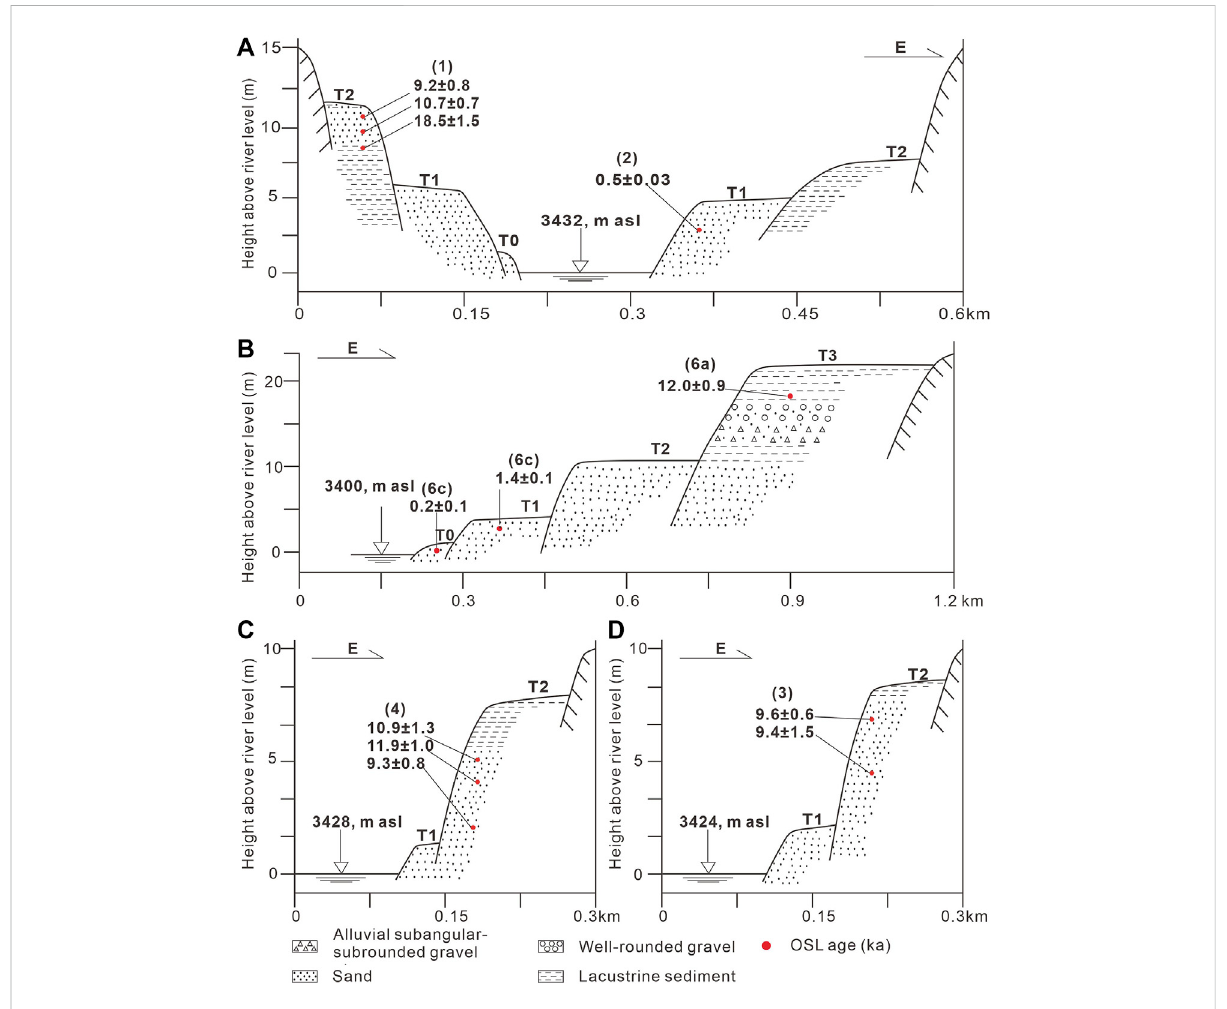
FIGURE 3 Schematic transverse sections of the terraces (sites 1 – 4 and 6), with dating